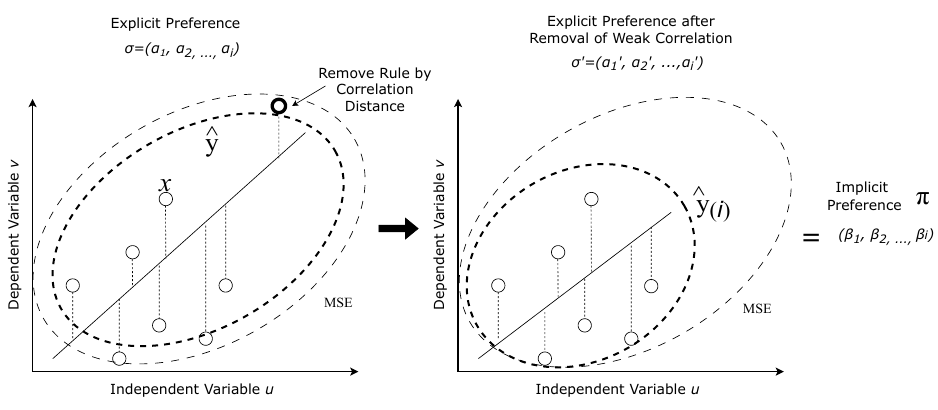
Figure 5. Overview of removing weak correlated multivariate rules and how residual difference ˆ y ( i ) − ˆ y can produce implicit preference Π